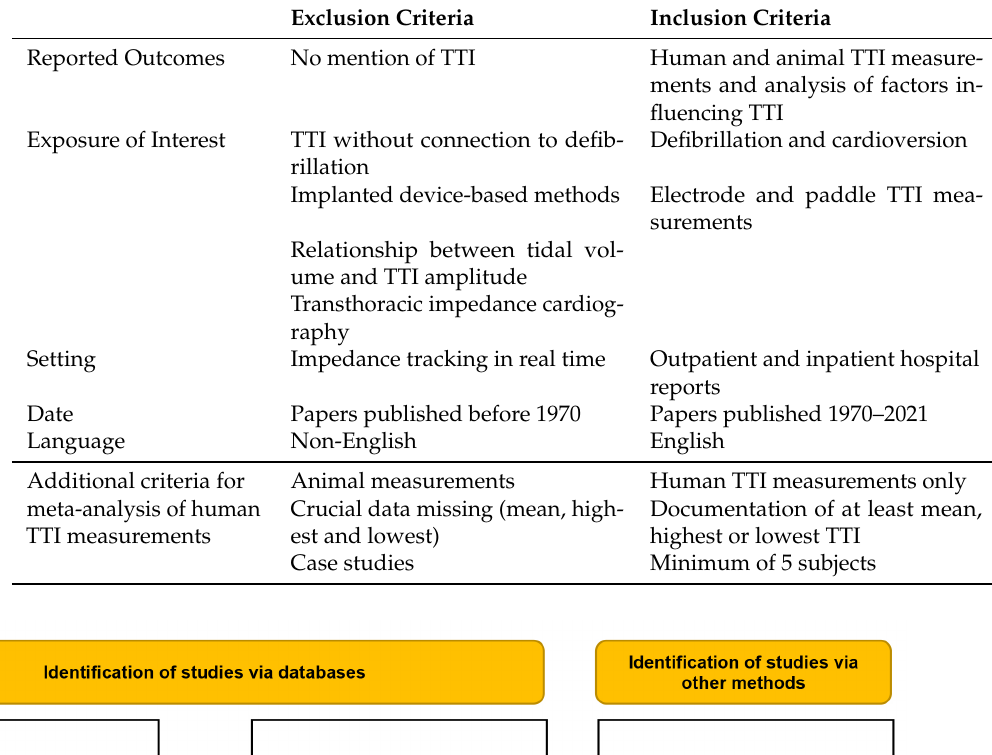
Table 1. Inclusion and exclusion criteria for the analysis of TTI influencing factors and meta-analysis of human TTI measurements.